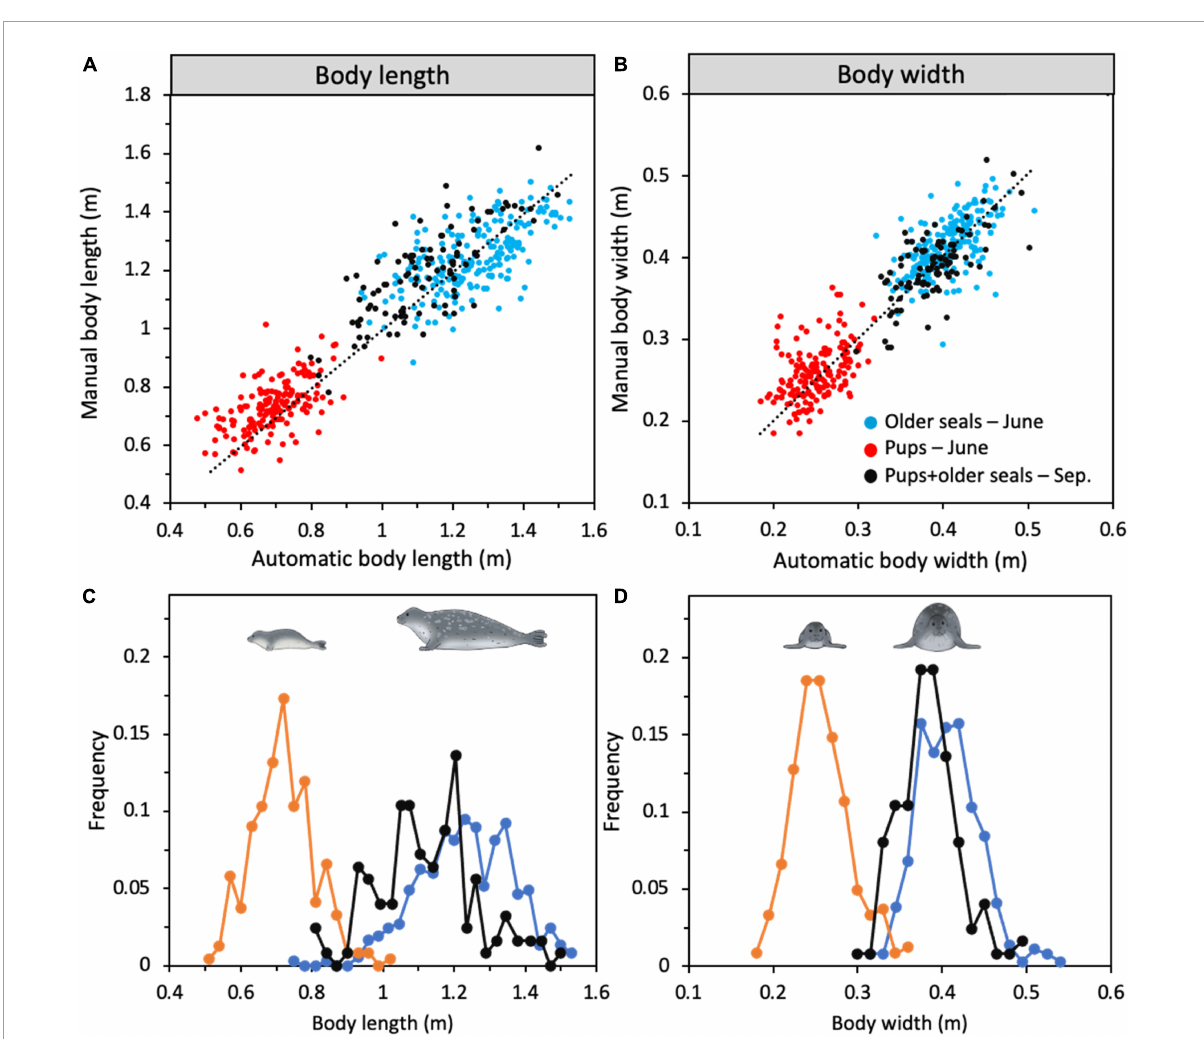
FIGURE5 Correlations between manually and automatically performed measurements on digital photos of (A) body length and (B) width ( N = 466) of harbour seals. Frequency distribution of (C) body length and (D) body width from the automatic measurements. In June, pups (orange line, N = 242) and older seals (light blue line, N = 251) could be identified as two separate groups on the photos by the machine learning detector (based on e.g., colour and shape) while in September all seals were pooled into the same category (black line, N =